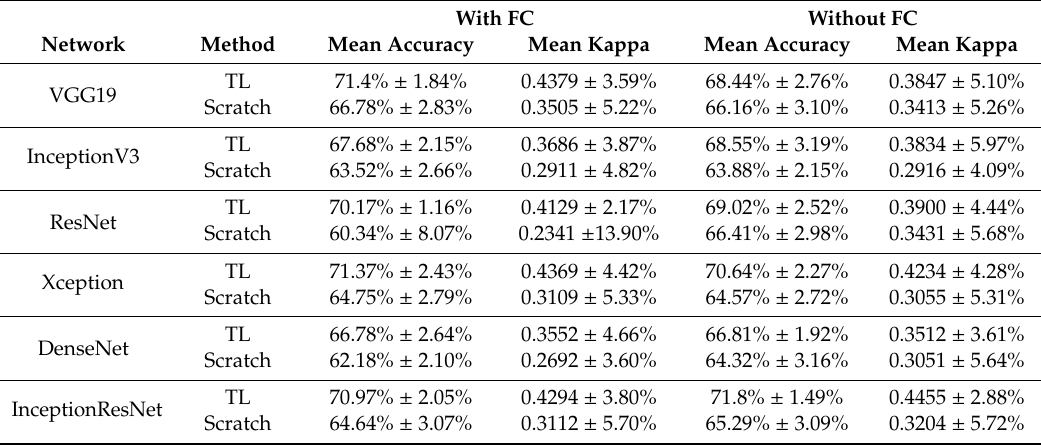
Table 7. Accuracy and Kappa scores of classifying finger images with and without fully connected layers ( ± 95%